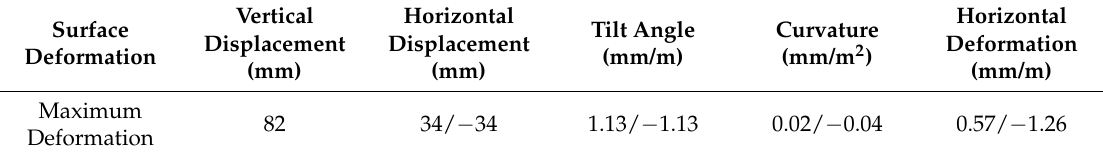
Table 14. Surface deformation after filling with the paste-like slurry.